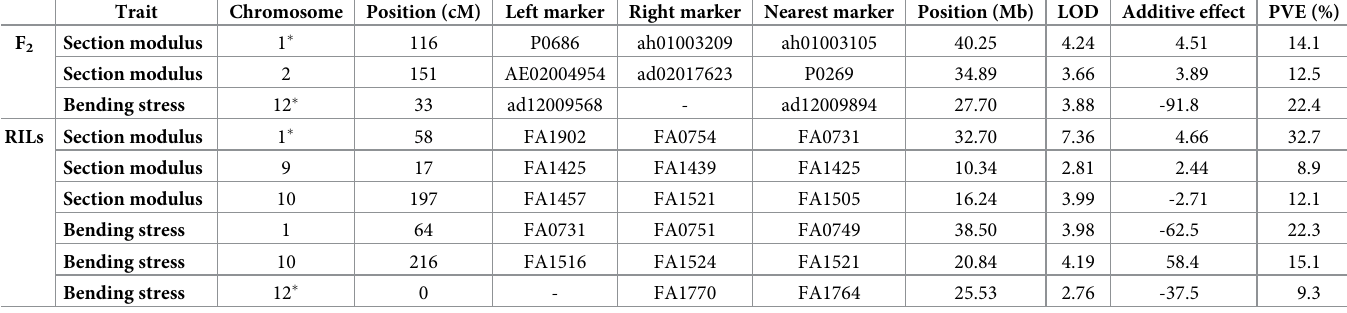
Table 6. Summary of QTLs detected in the F 2 and recombinant inbred lines from a cross between Monster Rice 1 and Takanari about breaking-type lodging resistance. Trait